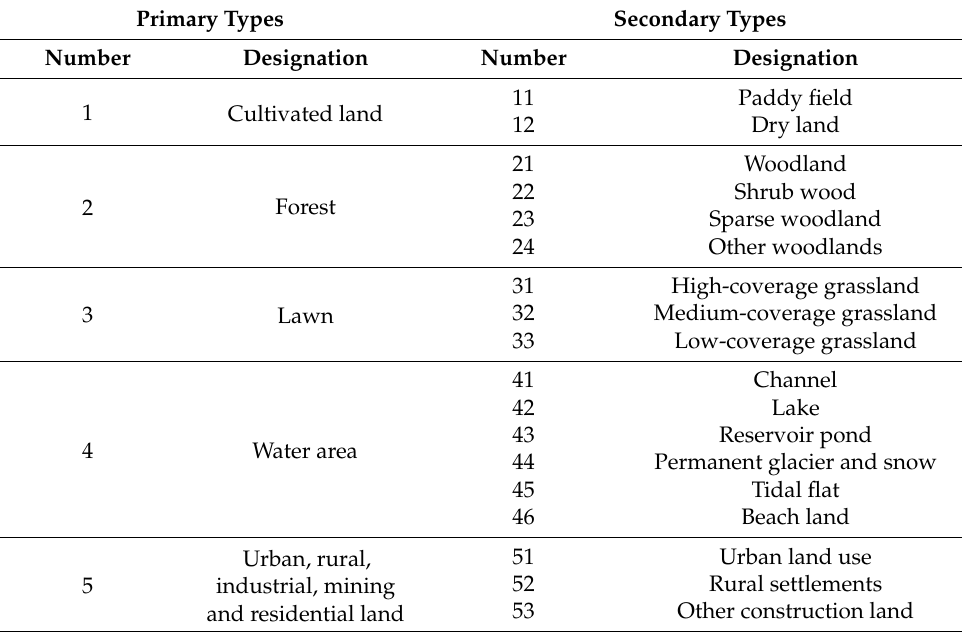
Figure 1. The distribution of land use types over China in 2020 [37]. The number of different land use types refers to the land use and cover change (LUCC) classification system, as shown in Table 1. The black boundary line represents the study area. Table 1. The land use types of LUCC classification system over China